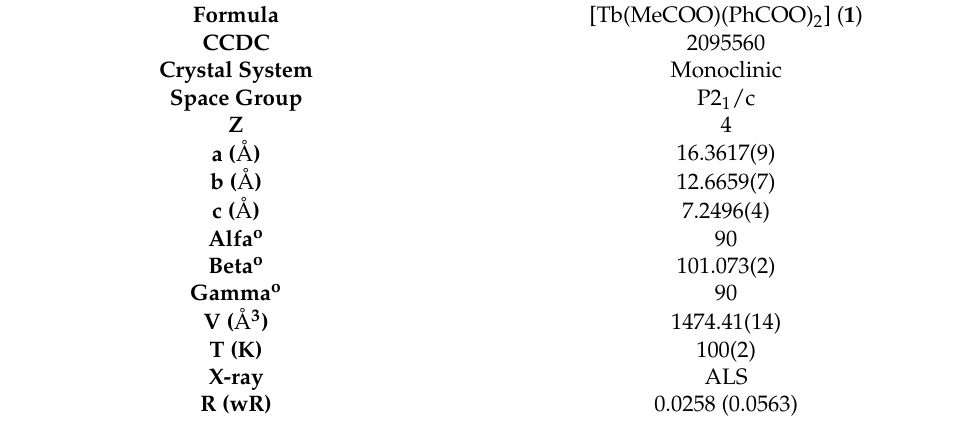
Table 1. Single crystal X-ray diffraction data for compound 1 .